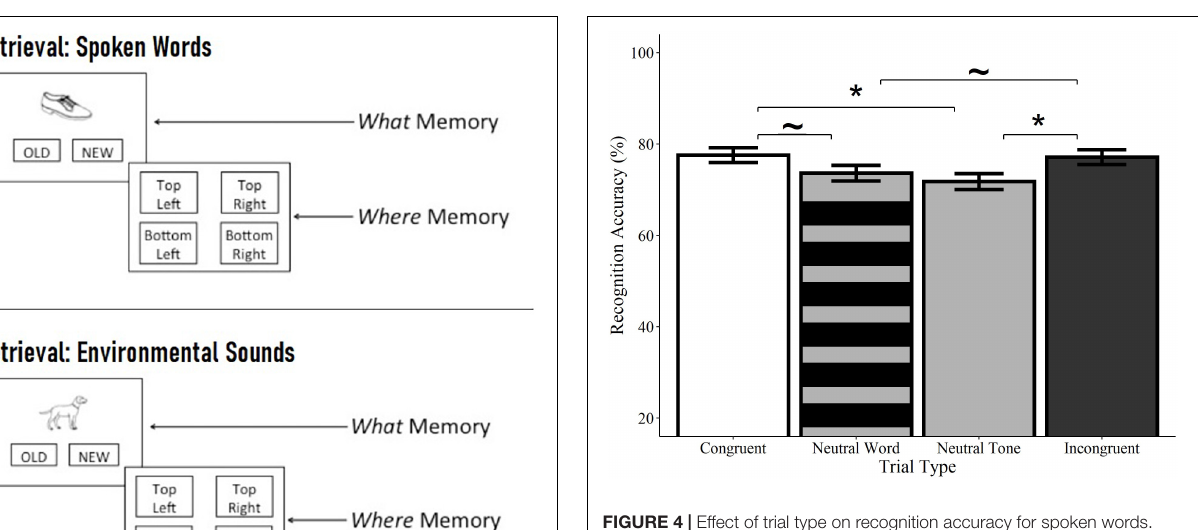
FIGURE 4 | Effect of trial type on recognition accuracy for spoken words. Visual objects initially paired with congruent (white) or incongruent (black) spoken words were recognized with significantly greater accuracy than those paired with neutral tones (solid gray) and with marginally greater accuracy than pictures paired with neutral words (striped gray). Accuracy did not differ between neutral tone and neutral word trials or between congruent and